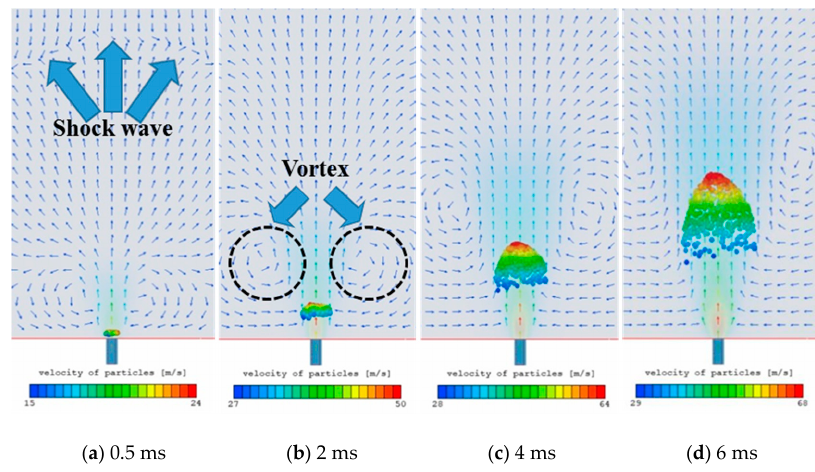
Figure 9. The simulated dispersion process of the quartz sand particles with an average diameter of 2.5 mm. ( a ) at 0.5 ms; ( b ) at 2 ms; ( c ) at 4 ms; ( d ) at 6 ms. Appl. Sci. 2020 , 10 , x FOR PEER REVIEW 10 of 15